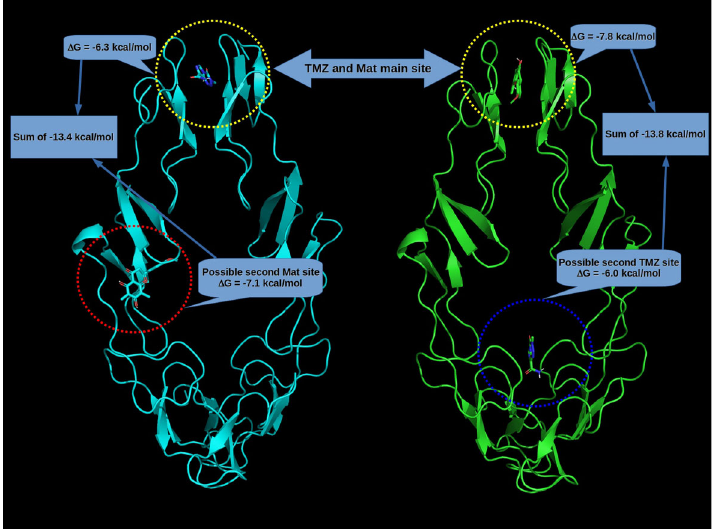
Figure 5. Two binding sites between TNFR1 (tumor necrosis factor receptor), matteucinol (Mat), and temozolomide (TMZ) with their docking